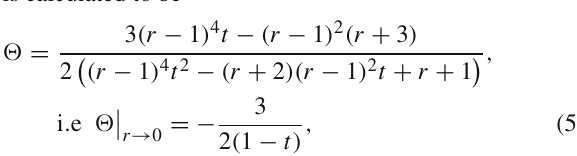
black and dot-dashed brown curves correspond to r = 0 . 001, 0.002, 0.01 and 0.02, respectively.